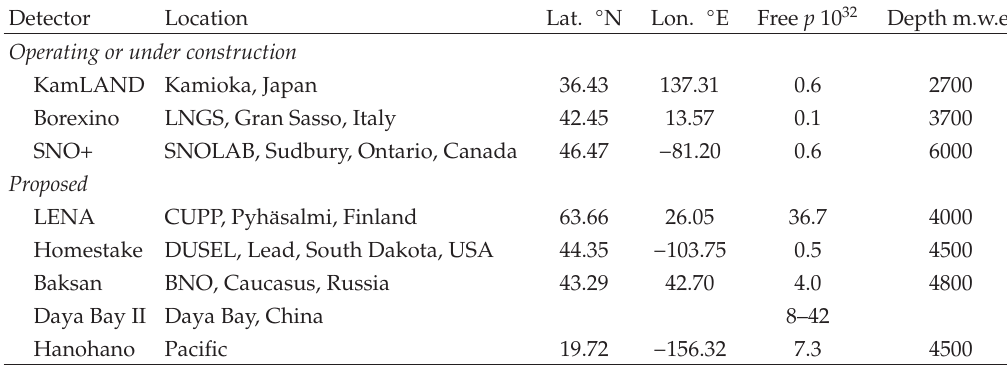
Table 6: Geographical location, size, and depth of geoneutrino detectors. Size in number of free protons, depth in meter water equivalent. Adapted from (cid:3) 38 (cid:4)